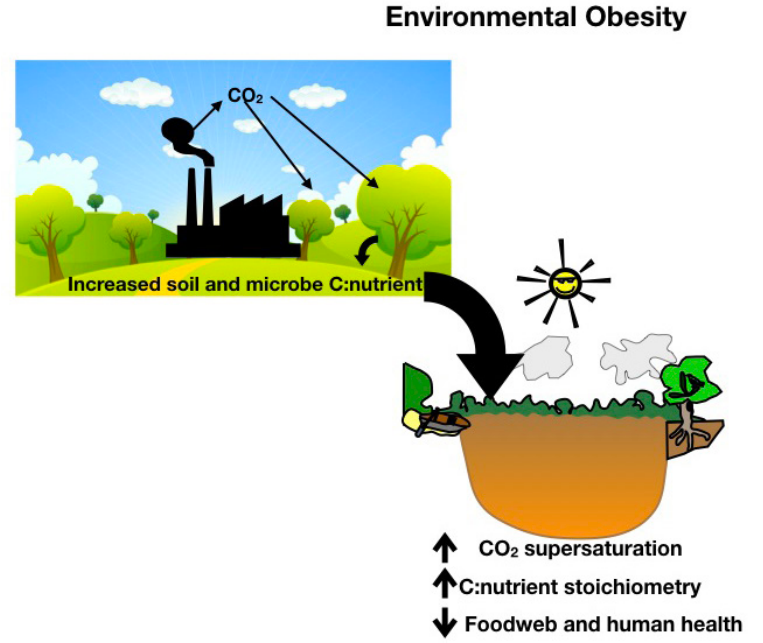
Figure 1. Hypothesized effects of increased CO atmosphere which increases the C:nutrient ratios of terrestrial plants and soil microbes, as well as the material that is exported to freshwaters. Similarly, the C:nutrient ratios of freshwaters increase due to excess CO but, perhaps more importantly, from exported organic and inorganic matter from terrestrial